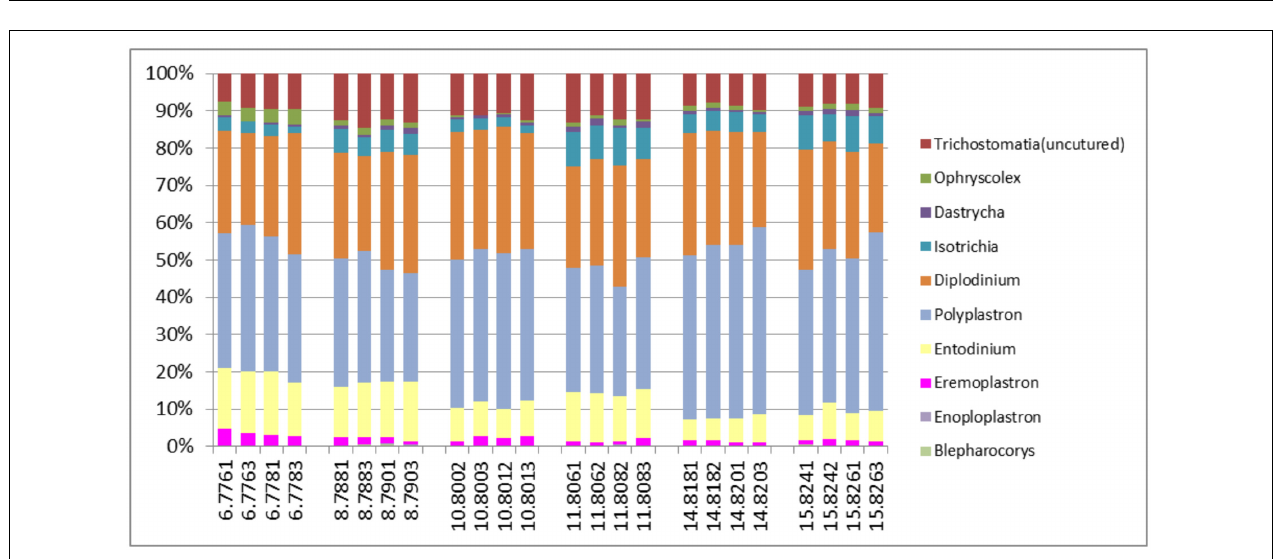
FIGURE 5 | Taxonomic distribution of the bacteria community in the V4 region extracted from total rRNA analysis, of solid-phase rumen contents of 6 cattle, 2 samples from each, analyzed in duplicates.